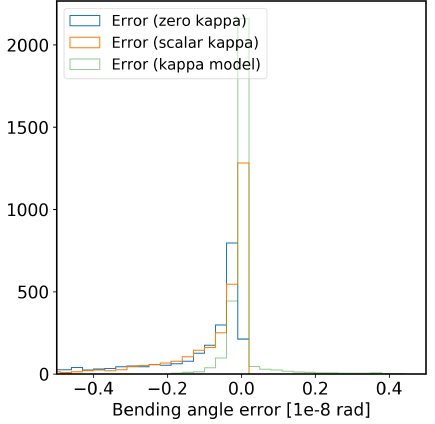
Figure 18. Histograms of nighttime bending angle errors for zero κ , scalar κ and modelled κ